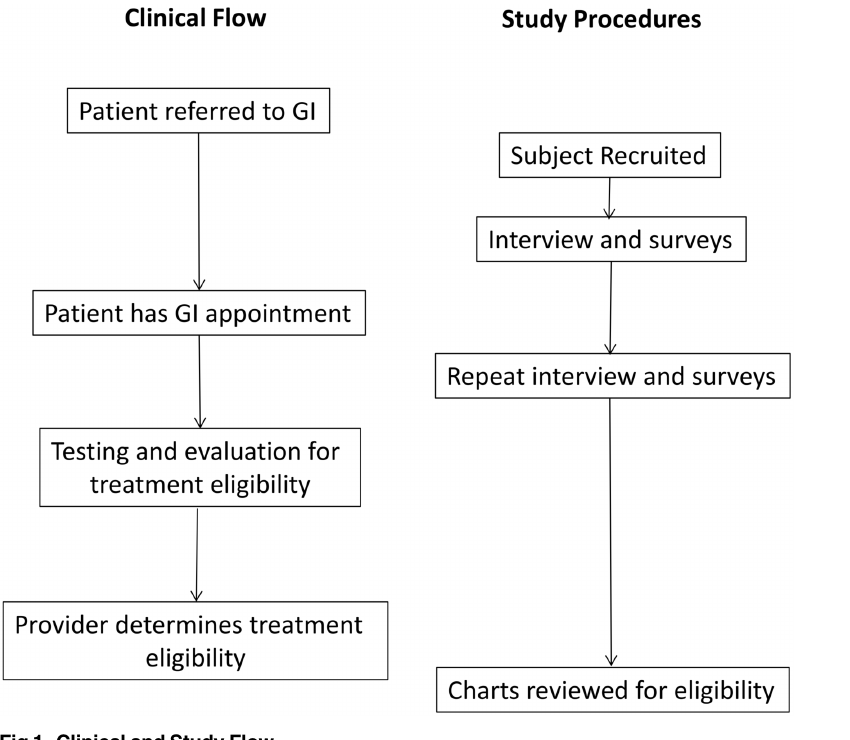
Fig 1. Clinical and Study